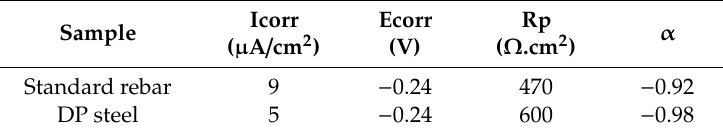
Figure 11. SEM images obtained after immersion in 0.3 M NaHCO 3 + 0.1 M Na 2 CO 3 (pH = 9.0) solution. ( a ) Standard rebar and ( b ) DP steel. Table 5. EIS results for DP steel and standard rebar in 0.3 M NaHCO 3 + 0.1 M Na 2 CO 3 (pH = 9.0) solution.